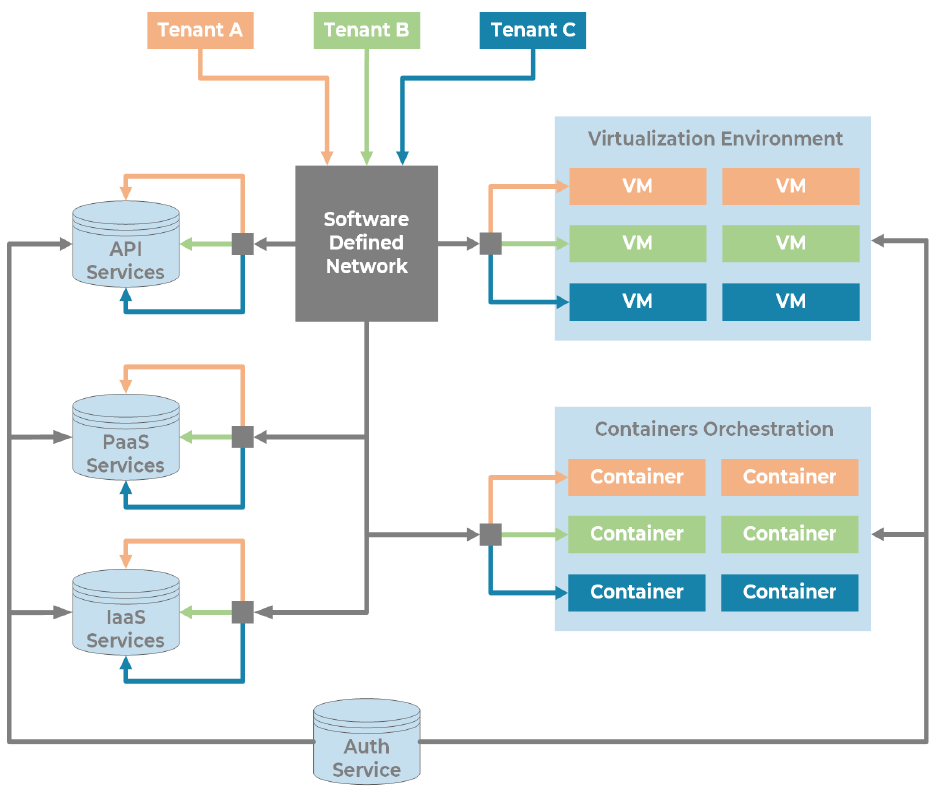
Figure 6. Multi-tenant